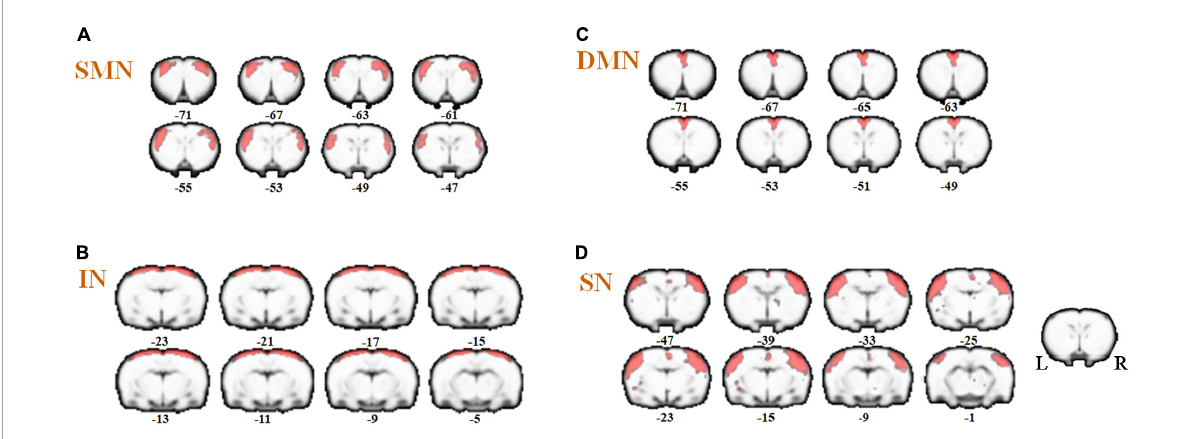
FIGURE3 Coronal views of spatial maps for each resting-state network. (A) sensorimotor network (SMN), (B) interoceptive network (IN), (C) default mode network (DMN), and (D) salience network (SN). Each RSN map was obtained using a one-sample t -test across all individual IC patterns (FWE, P < 0.05). The right hemisphere of the brain is on the right side of the image.